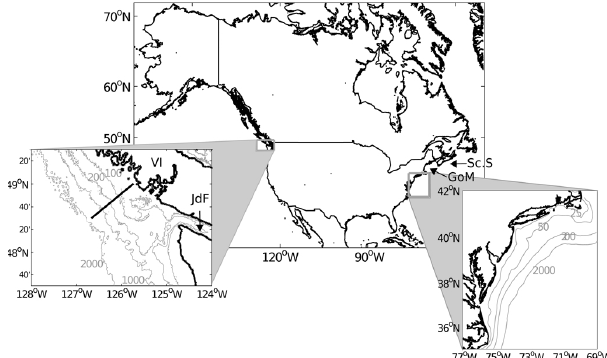
Fig. 2. Map of North America showing the Middle Atlantic Bight (MAB) in the east (right inset) and the Vancouver Island Shelf (VIS) in the west (left inset). The location of the transect represented by the VIS model is shown by the black line in the left inset, which also shows the 100, 200, 1000, and 2000m isobaths off the VIS. The in- set on the right shows the 25, 50, 200, and 2000m isobaths from the MAB model bathymetry. Legends in the plot indicate key locations mentioned in the text: Vancouver Island (VI), Juan de Fuca Strait (JdF), Gulf of Maine (GoM), and Scotian Shelf